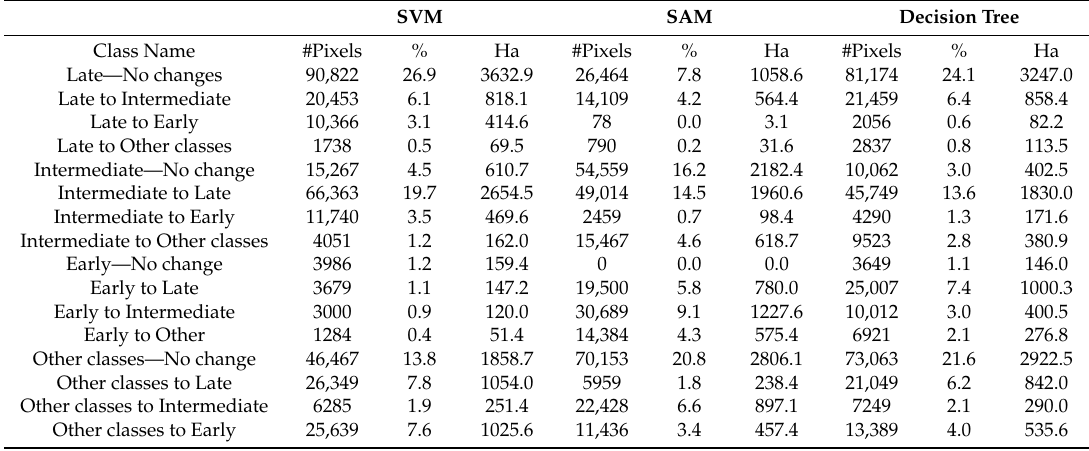
Table 6. Land cover/land use changes in PEMS between 2008 and 2014. SVM